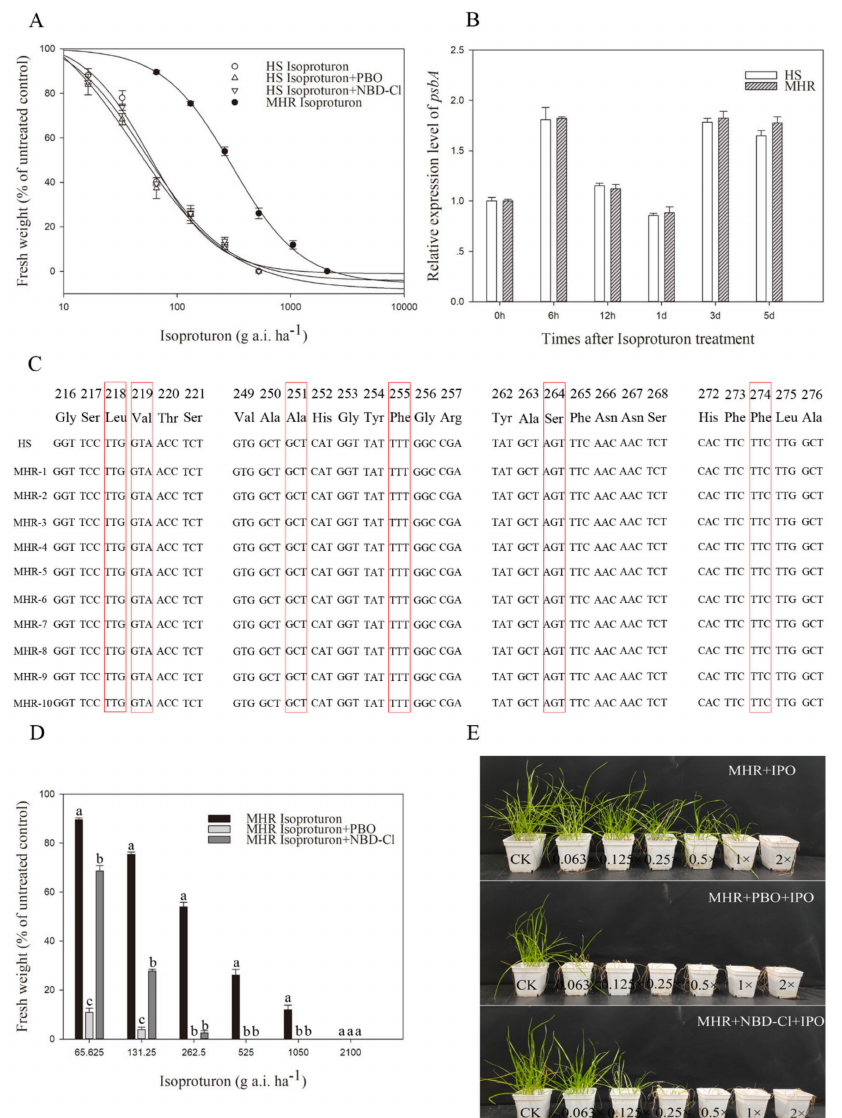
Figure 3. The MHR population has evolved resistance to PSII-inhibiting isoproturon. ( A ) Percentage fresh weight with isoproturon and/or P450 inhibitor treatment in the whole-plant dose-response assay. ( B ) psbA gene expression analysis. ( C ) Nucleotide sequence of the psbA gene in HS and MHR L. multiflorum biotypes. ( D ) Biomass difference in MHR populations treated with isoproturon in the absence and presence of CYP450 inhibitor PBO and GST inhibitor NBD-Cl. ( E ) Phenotype differences in HS and MHR populations treated with isoproturon (IPO) in the absence and presence of CYP450 inhibitor PBO and GST inhibitor NBD-Cl. Vertical bars represent the mean ± SE. Amino acid sequence positions refer to the sequence of psbA from Arabidopsis thaliana (GenBank accession number X79898.1). Seven positions endowing resistance to PSII inhibitors are marked with red boxes. Different letters indicate different significance levels ( t -test, p <